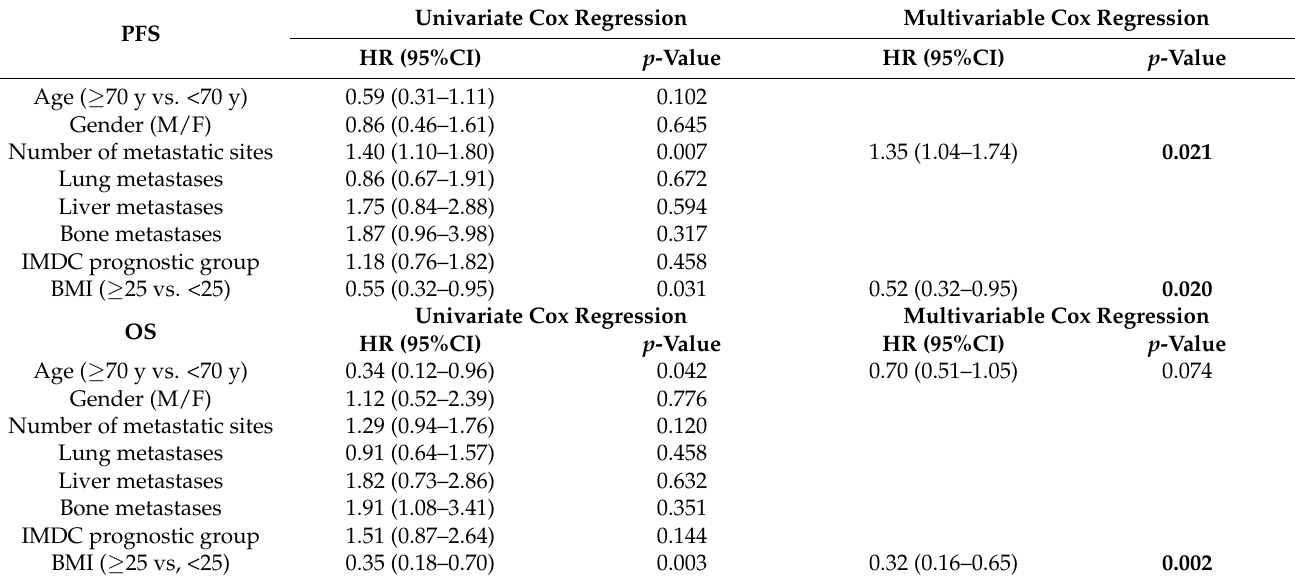
Table 4. Univariate and multivariate analyses of predictors of progression-free survival and overall survival in patients treated with cabozantinib as third-line